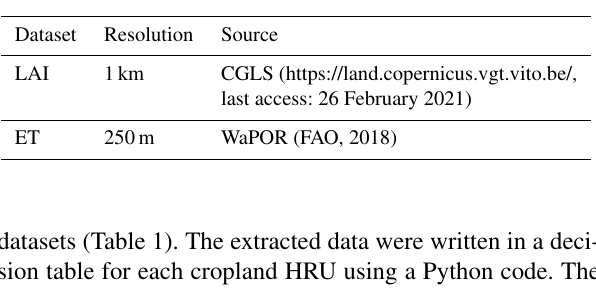
Table 3. Remote sensing datasets used for model